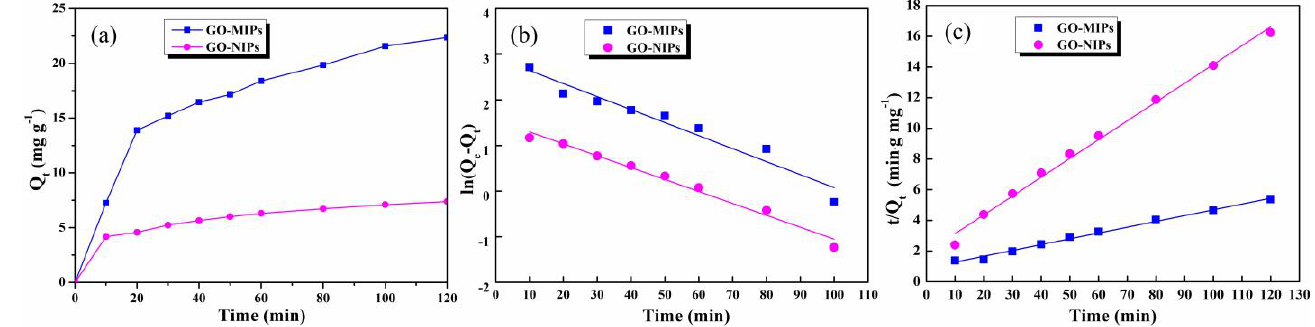
Figure 4. Dynamic adsorption ( a ), pseudo-first-order kinetic for adsorption ( b ), and pseudo-second- order kinetic for adsorption ( c ) of GO-MIPs and GO-NIPs.